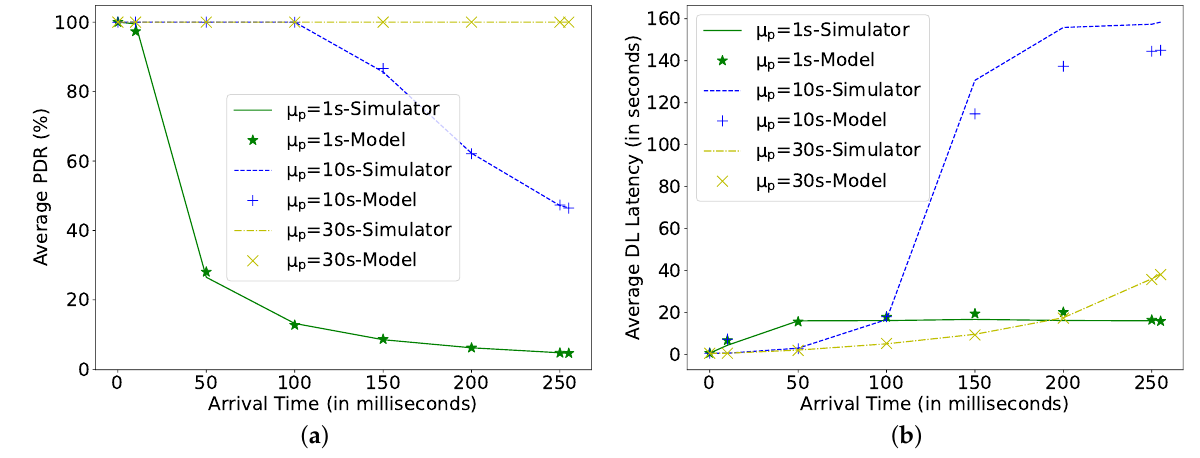
Figure 13. Comparing simulator and model for different arrival times (AT) at C = 4 mF, P h = 1 mW, N = 16, T PI = 1 s. ( a ) Average packet delivery ratio; ( b ) DL latency.